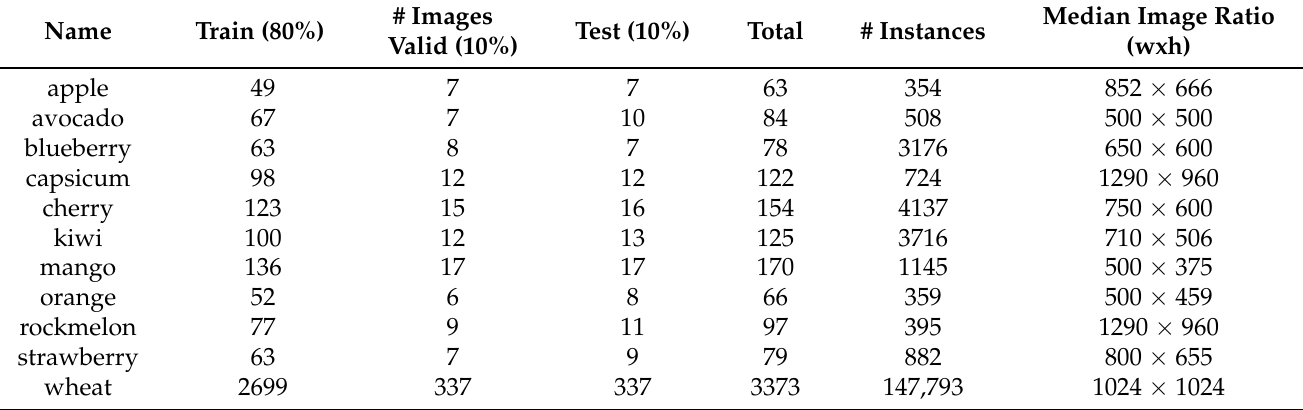
Table 3. Dataset for object detection summary